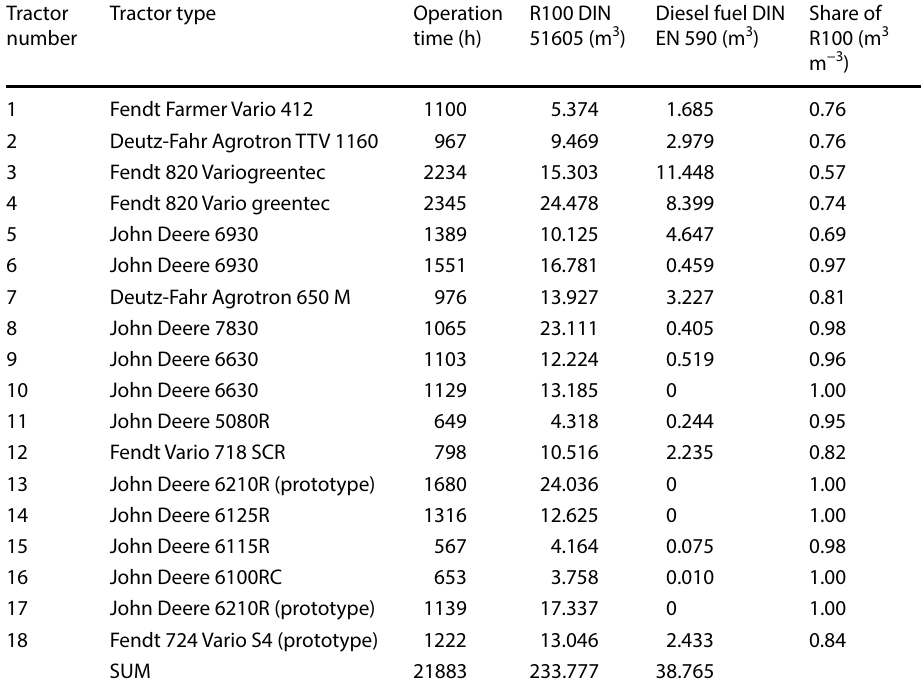
Table 4 Fuel consumption of the monitored tractors in the years 2015 to